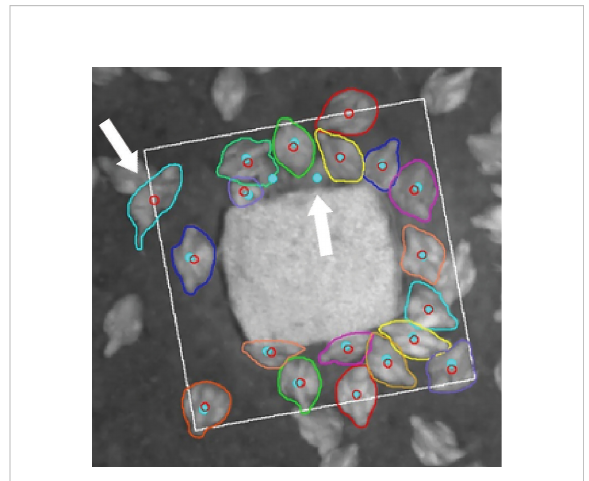
FIGURE 4 Example of evaluation method for bale use. Manually annotated broilers are marked with a solid cyan dot, detected broilers using the bale are marked with an open red circle. Some broilers were not detected and assigned to the bale zone, and some were assigned to the zone which were on the zone edge and were not manually annotated (indicated with arrows).